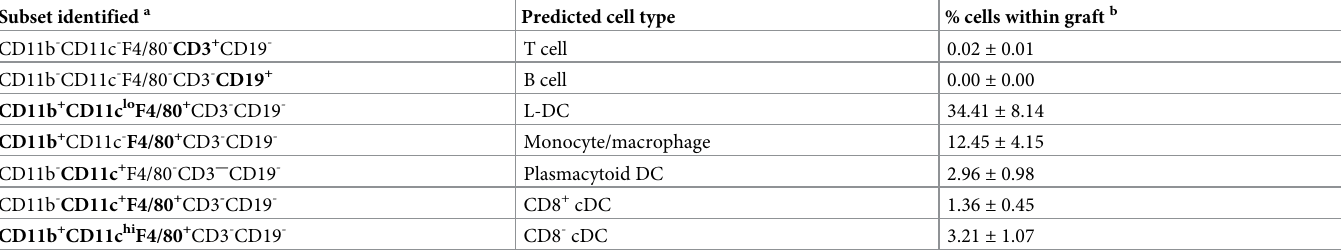
Table 2. Representation of hematopoietic cells within 3B5